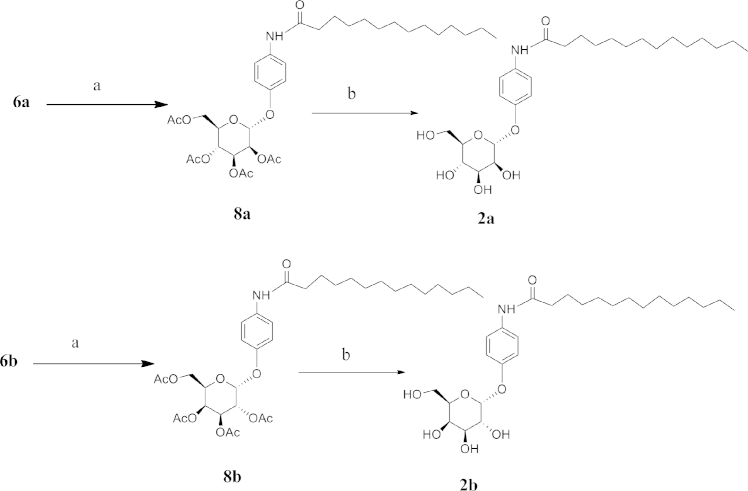
Reagents: (a) Myristic Acid, EDC, DMAP, CH2Cl2, (b) NaOMe/MeOH.